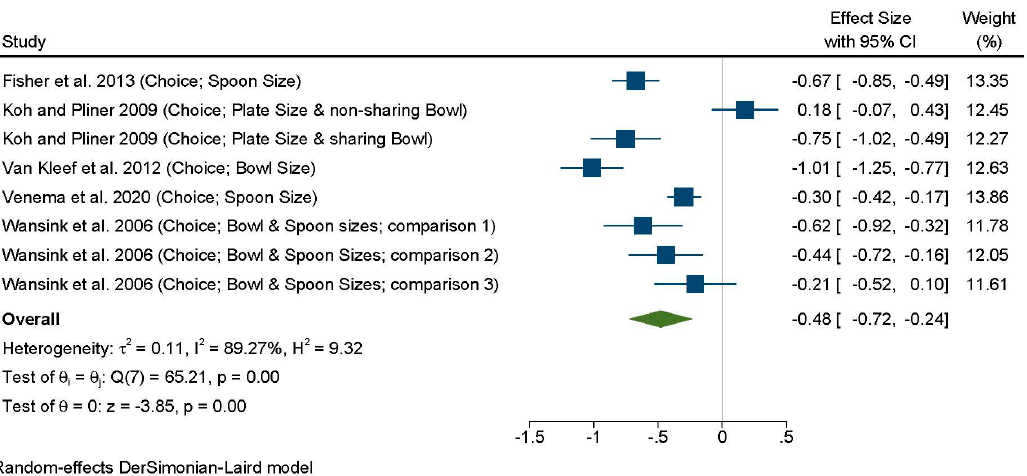
Figure 4. Forest plot for the analysis of all comparisons examining the effects of portion control tools on portion size choice (served amount) using random-effects meta-analysis. Contributing comparisons are represented by a filled square with horizontal lines, where the area of the square depicts the contribution of the study to the full analysis, and the hor- izontal lines indicate the 95% CIs for each study. Studies displaced to the left of a 0 line demonstrate a finding in favor of the portion control tool to reduce serving sizes, whereas those to the right demonstrate a finding in favor of the portion control tool promoting an increase on served amounts when compared with the control condition. The diamond at the base of the plot represents the combined effect (Standardized Mean Difference) with 95% CIs. Wansink et al. 2006 Com- parison 1—Small bowl combined with small spoon vs. Large bowl combined with large spoon. Wansink et al. 2006 Comparison 2—Small bowl combined with large spoon vs. Large bowl combined with large spoon. Wansink et al. 2006 Comparison 3—Large bowl combined with small spoon vs. Large bowl combined with large spoon.